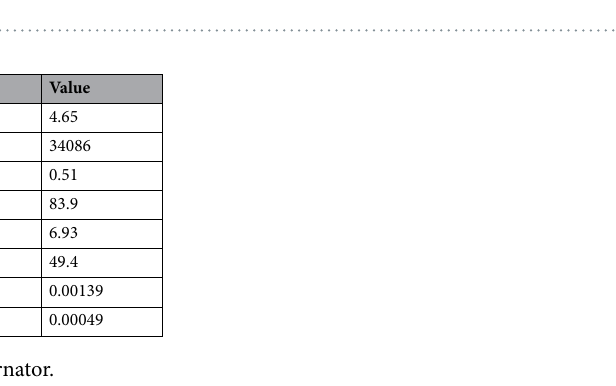
Table 2. Parameters of the linear